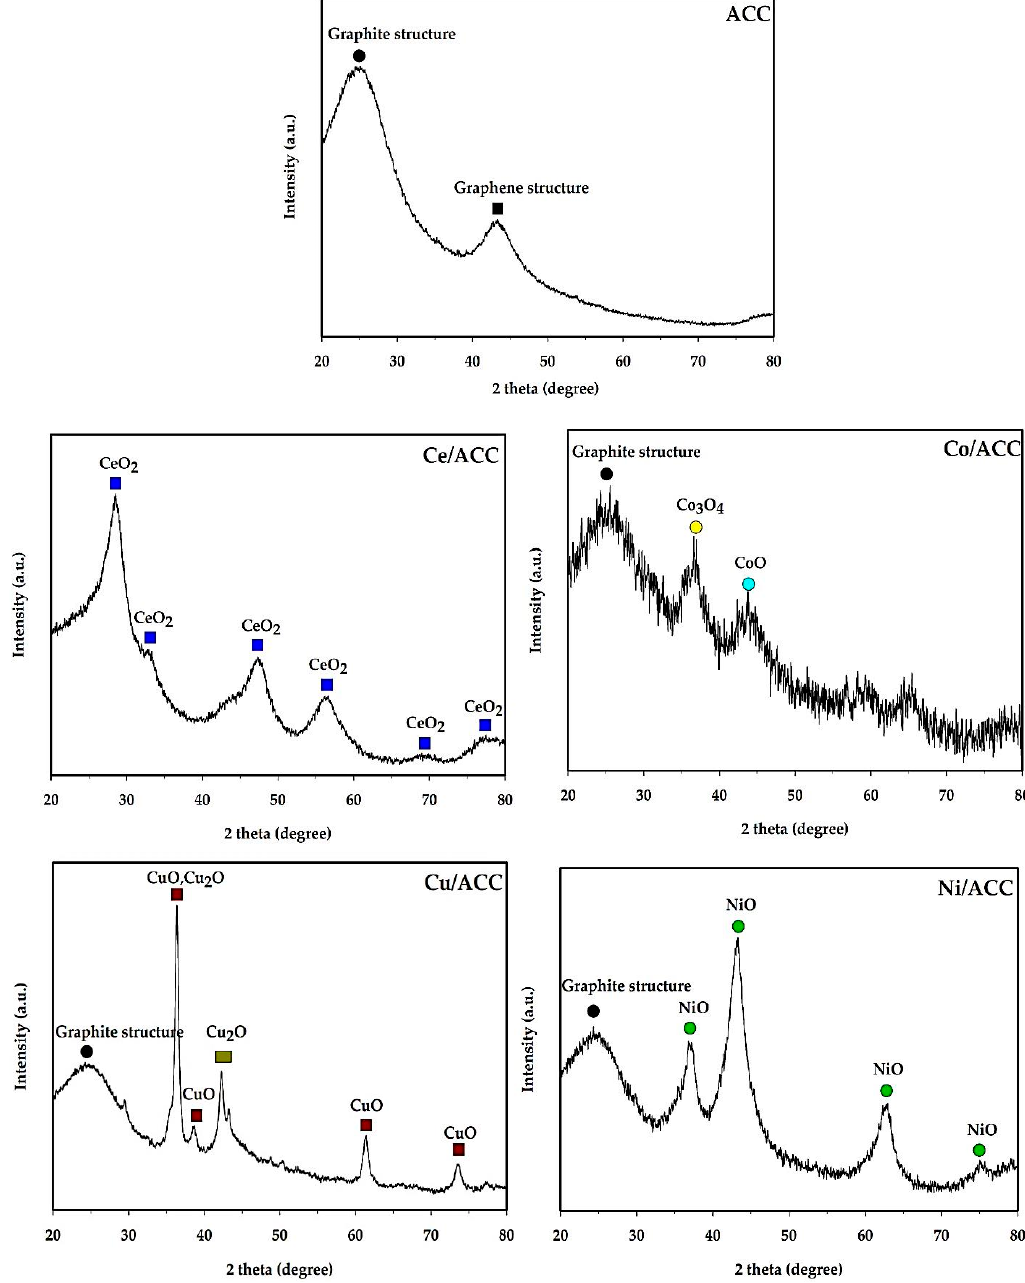
Figure 5. X-ray diffraction patterns of catalysts.